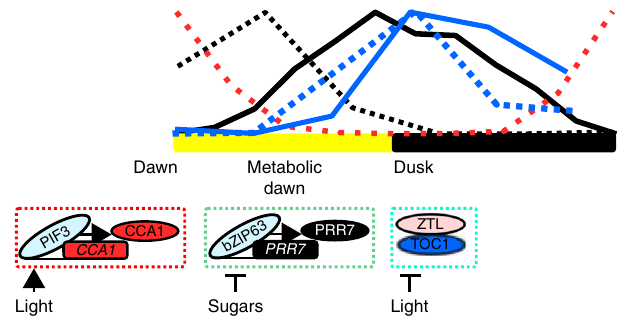
Fig. 4 Dynamic phase adjustment of circadian oscillator through regulation of individual components. Entrainment occurs through signalling to individual components based on their temporal availability. At dawn, light- regulated transcription factors, including PIF3, regulate CCA1 expression 33 , sugars regulate bZIP63 to modulate PRR7 expression to establish a metabolic dawn 16,24 and dusk is sensed through ZTL-mediated degradation of TOC1 protein in the dark 29 . Each entrainment event is semi-discrete, can have potential for downstream components, but might also be temporally restricted due to subsequent inputs. The sequential nature is akin to a signalling pathway rather than the resetting of an entire clock mechanism.